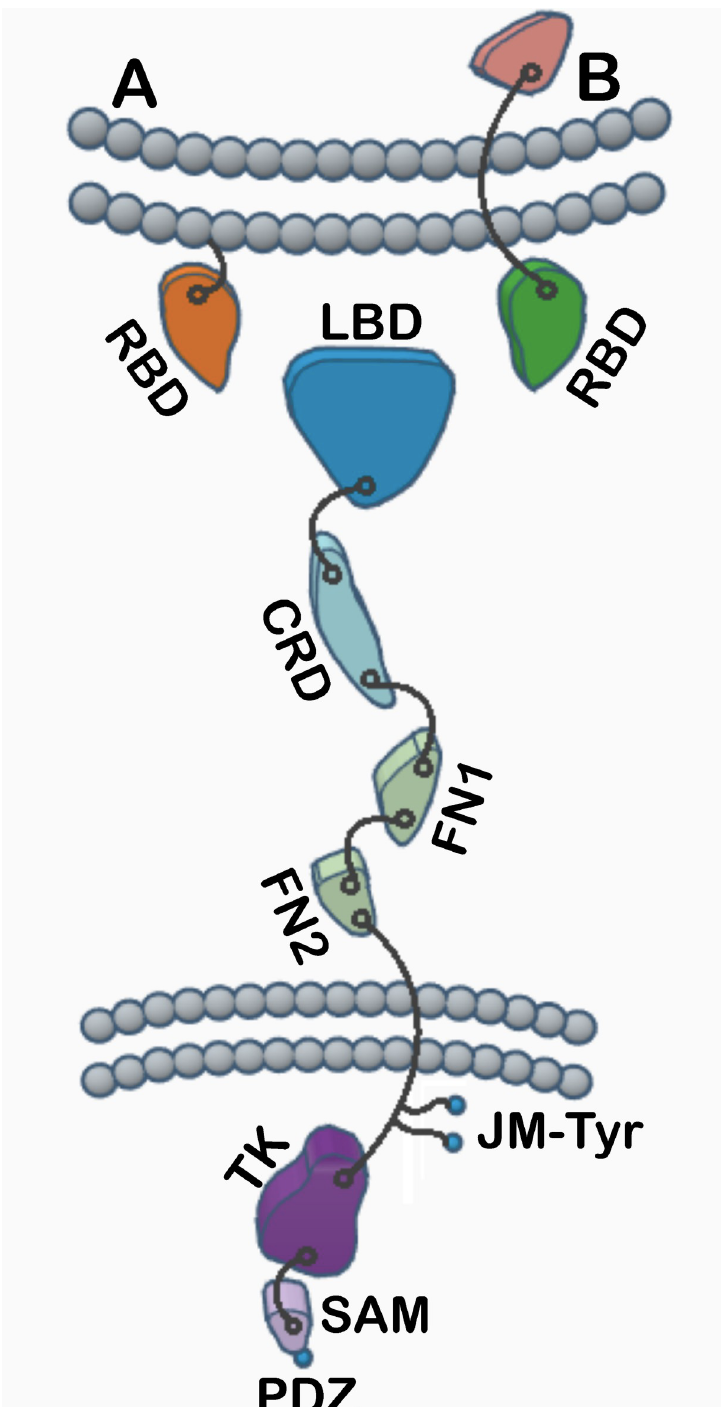
Fig 1. Domain organization of Eph receptors and ephrin ligands. Class A and class B receptor-binding domains (RBDs), ligand-binding domain (LBD), cysteine-rich domain (CRD), fibronectin-type-3 region (FN1 and FN2), juxtamembrane tyrosine residues (JM-Tyr), tyrosine kinase (TK), sterile alpha motif (SAM), PDZ-binding motif (PDZ).